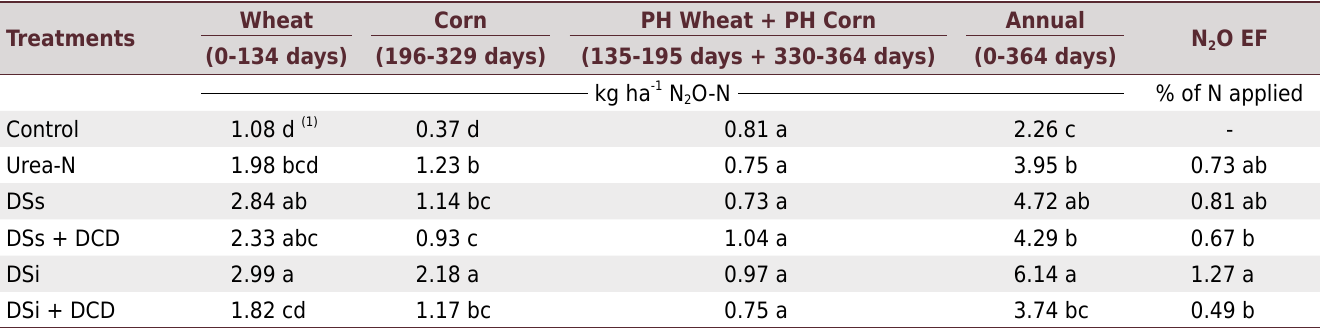
Table 3. Cumulative N 2 O emissions during wheat and corn growing seasons and post-harvest (PH), and N 2 O emission factor (EF) Treatments